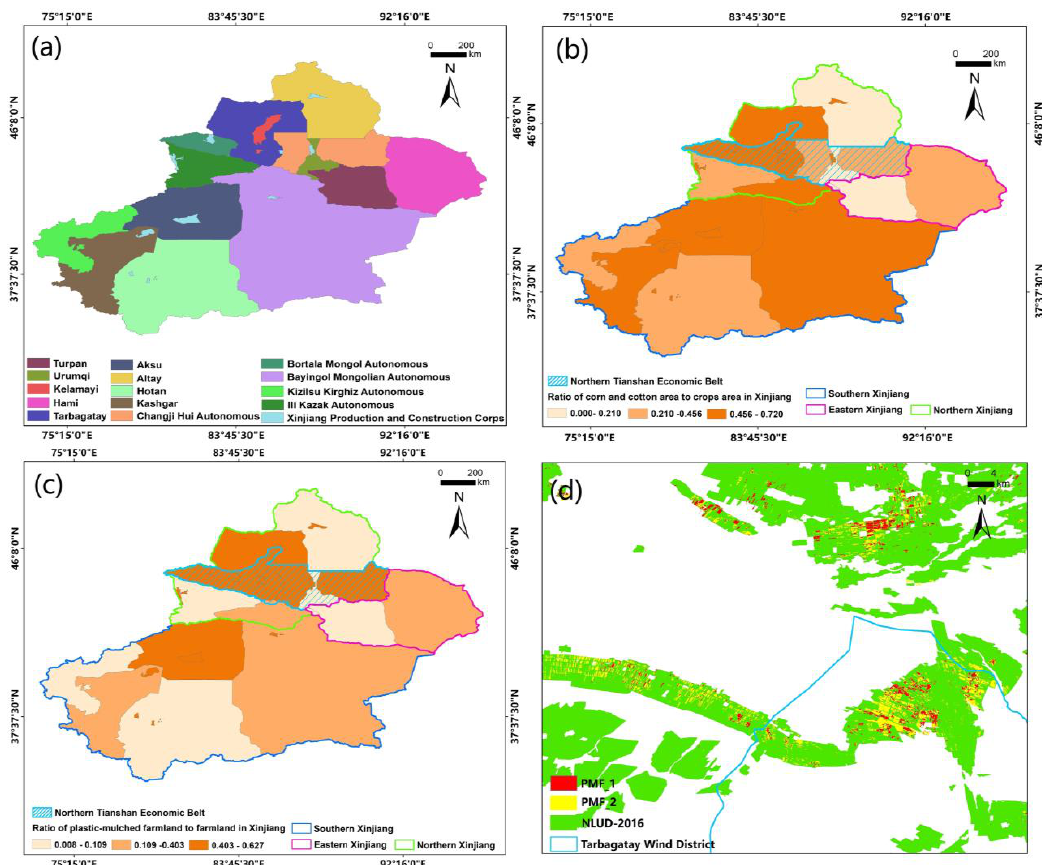
Figure 8. The possible factors behind the spatial distribution of PMF. ( a ) The administrative division of Xinjiang; ( b ) the ratio of PMF to total cropland (the cropland data from NLUD-2016 in 2016); ( c ) the ratio of corn and cotton area to all crops area in Xinjiang; and ( d ) the distribution of PMF2 in the Tarbagatay Prefecture wind district.